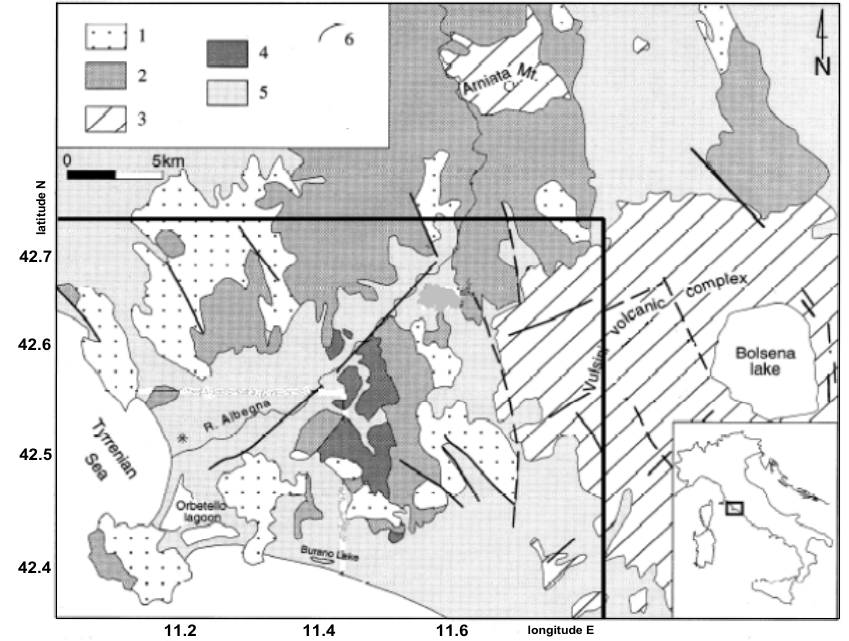
Figure 3. Geological sketch map of Albegna Basin. Legend: 1=Tuscan units; 2=Ligurian units; 3=Mt. Amiata and Vulsini volcanic units; 4=Miocene clastic deposits; 5=Pliocene-Holocene sedimentary units; 6=normal faults; the rectangle on the map refers to the area re- ferred in this